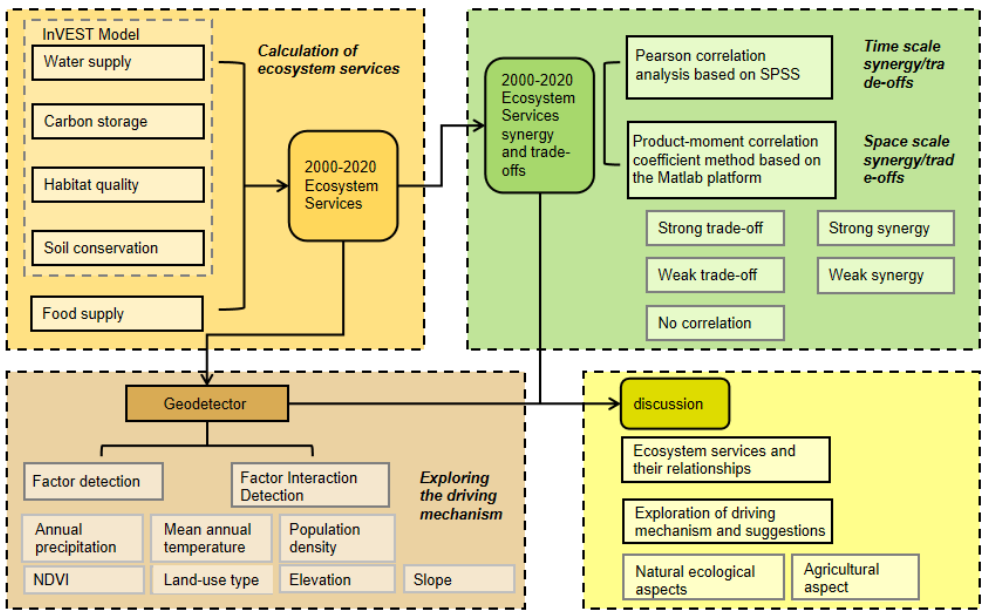
Figure 2. The research